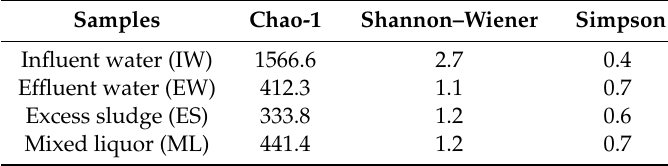
Table 4. Species richness, diversity, and evenness indices in wastewater treatment plant.